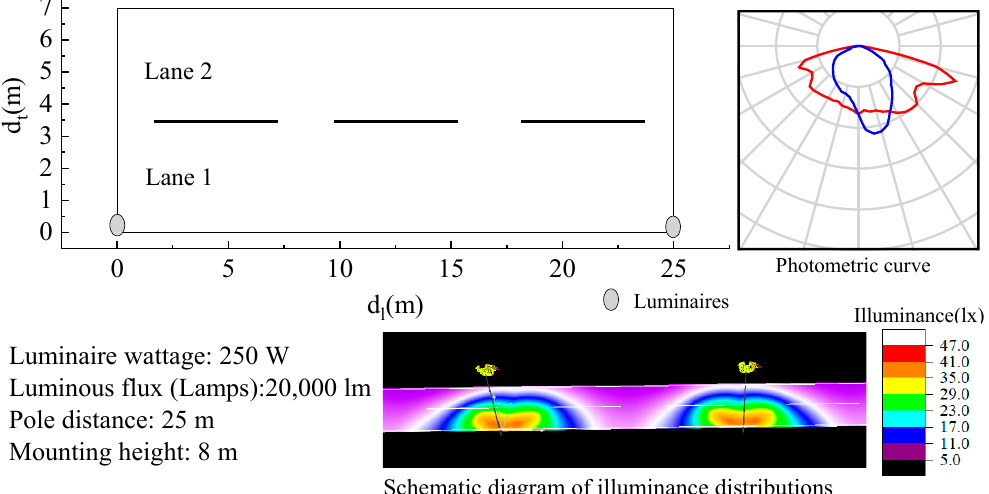
Figure 1. Road lighting setup taking the single type for example. Most setups, except the number of lanes, for the double and staggered types are the same as the single type.